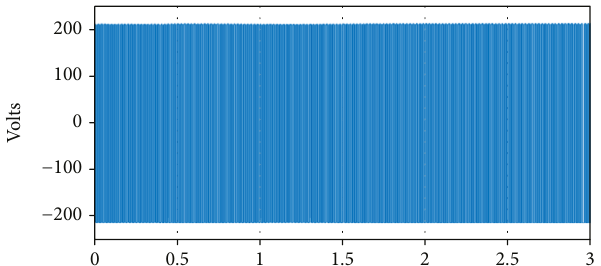
Figure 22: Single-phase step-up transformer output voltage/load